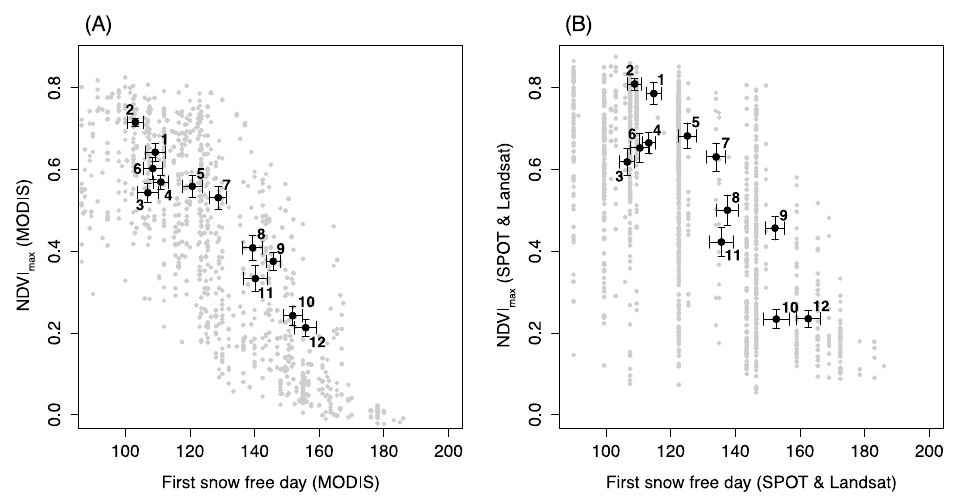
Figure 10. The first snow free day (Julian Day) and peak NDVI (NDVI max ) for 2015 represented by grey dots, measured by ( A ) MODIS; and ( B ) SPOT-5 and Landsat-8 images for 1272 vegetation plots. Black points and error bars represent the mean position with confidence intervals of the twelve plant communities detailed in Table 1. Values of NDVI close to 0 represent plant communities occurring in sparsely vegetated screes and talus. The overall upward shift in NDVI values for SPOT-5 and Landsat-8 imagery as compared to MODIS NDVI can be attributed to more homogenous plant cover occurring within smaller pixels. The error bars represent 95% confidence intervals around estimates of mean NDVI max and the first snow free day per plant community.